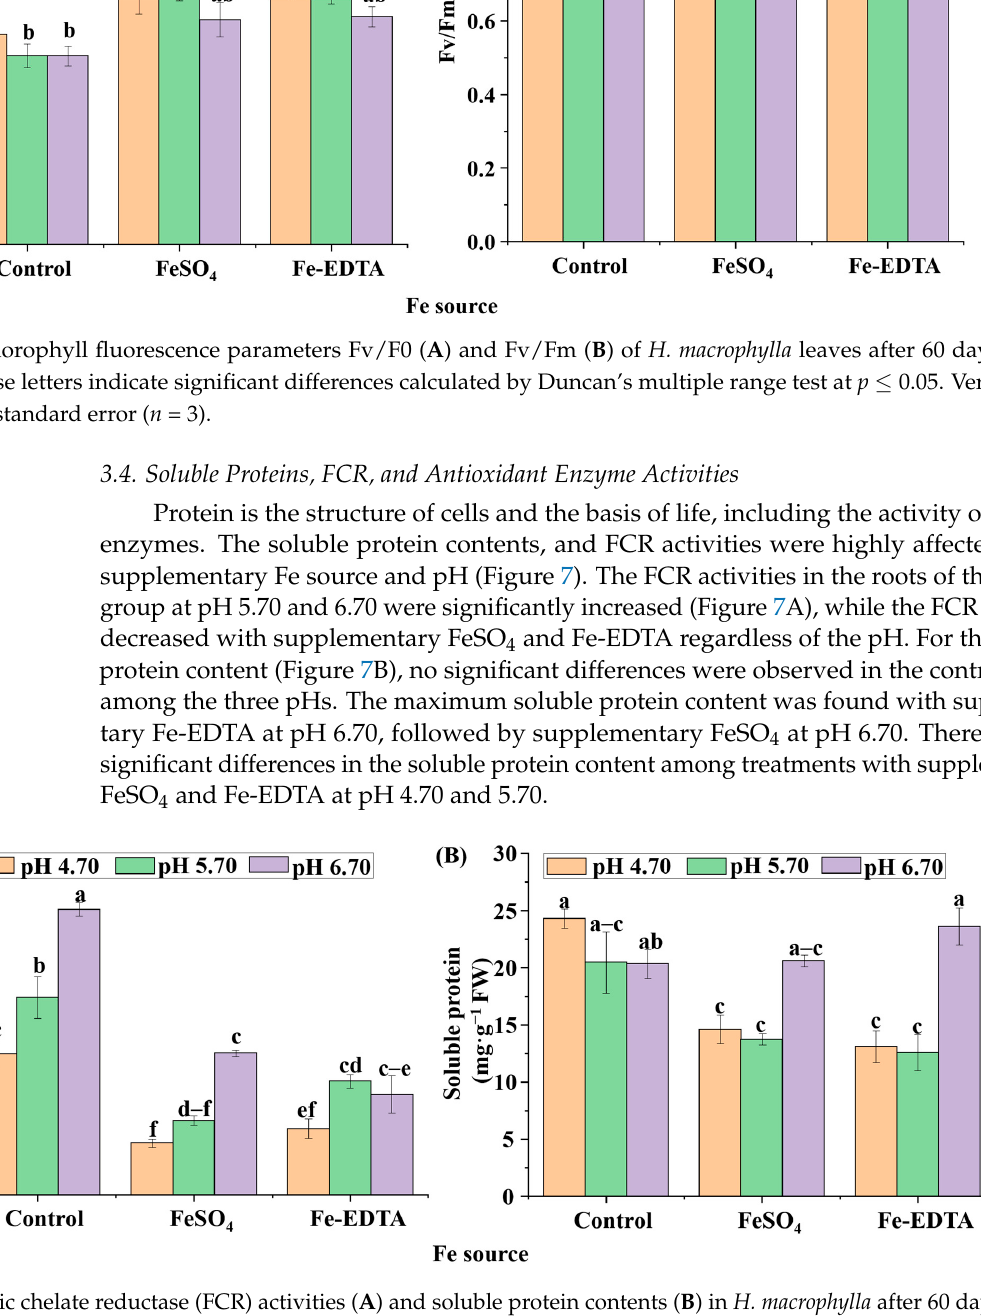
Figure 7. The ferric chelate reductase (FCR) activities ( A ) and soluble protein contents ( B ) in H. macrophylla after 60 days of culture. Lowercase letters indicate significant differences calculated by Duncan’s multiple range test at p ≤ 0.05. Vertical bars indicate the standard error ( n = 3).